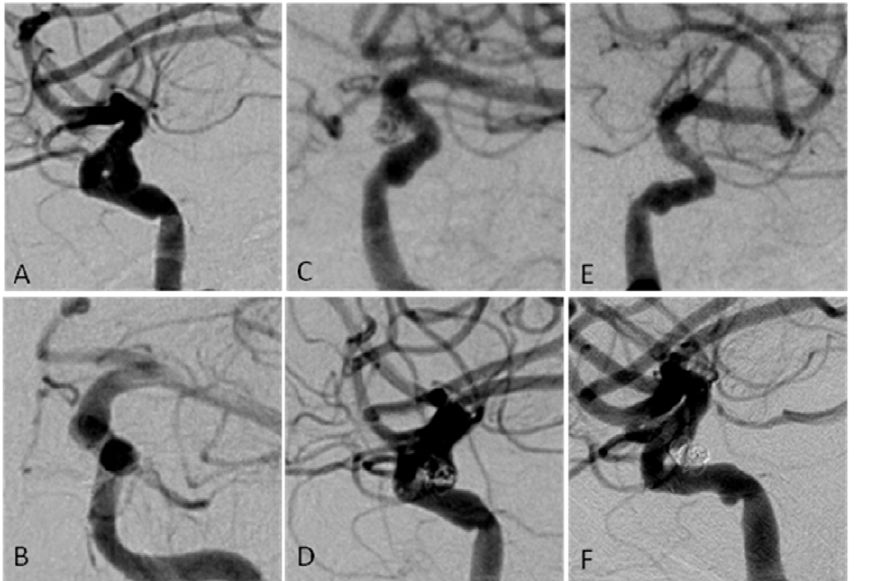
Figure 3. A 64 year old woman presenting with vision impairment was found to have an aneurysm measuring 5 mm that was located in the supraclinoid ICA segment. Pre-treatment angiographic imaging (A and B) revealed a saccular wide-necked aneurysm which was accessible by SAC. A Neuroform stent was successfully navigated, deployed and subsequent coiling was performed. Immediate post-treatment results (C and D) demonstrated only partial occlusion of the aneurysm and flow beyond the aneurysm neck was present. At 6-months follow-up imaging (E) no residual flow into the aneurysm sac was detectable. These results were stable at 18-months follow-up imaging (F) and emphasize the potential of aneurysms to undergo progressive occlusion after treatment by stent-assisted